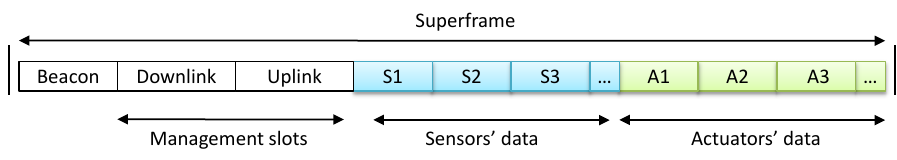
Figure 11. 802.15.4e FA MAC superframe structure